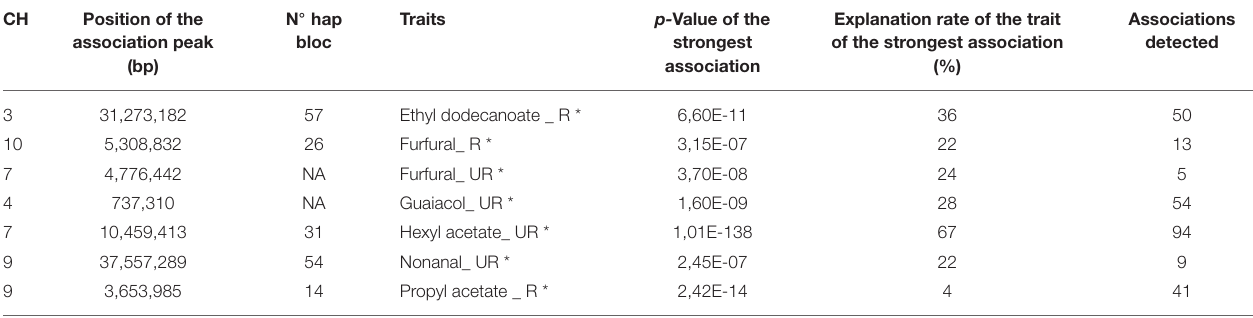
TABLE 5 | Most significant associations for biochemical compounds related to other pathways.